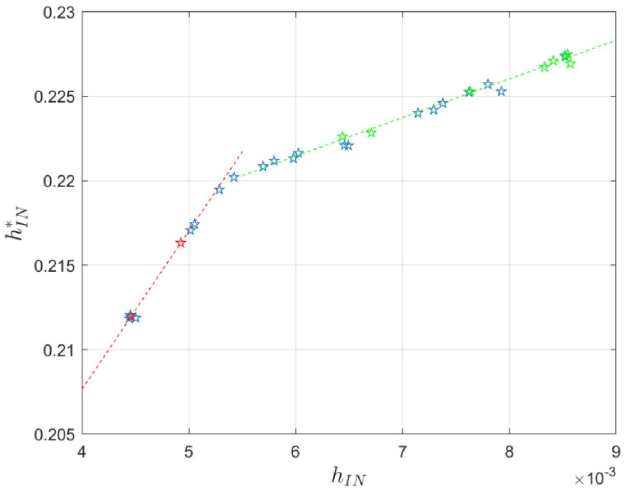
Fig. 5. Piecewise af fi ne input transformation equation (2). Stars indicate measured data-points.